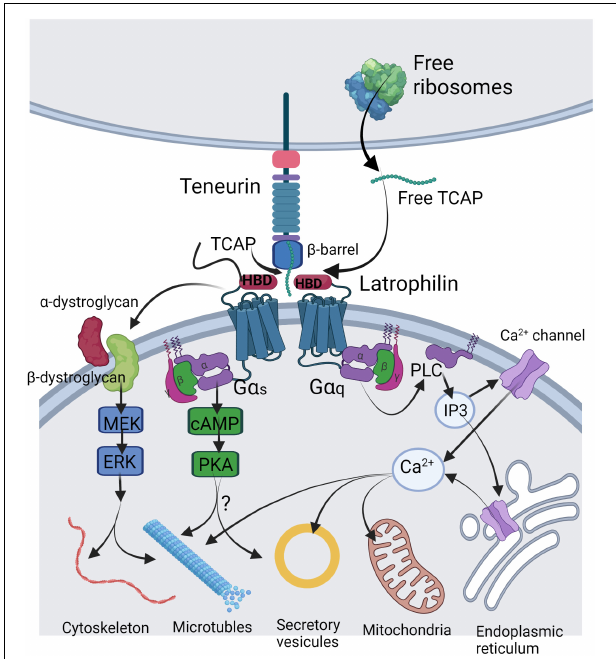
FIGURE 1 | Illustration of the mechanisms of TCAP release and its molecular targets in a generalized neuron. TCAP may be liberated by either autoproteolytic cleavage from the C-terminus of the teneurin or by translation of a short mRNA from the free ribosomes. Soluble TCAP binds to the hormone-binding domain (HBD) of latrophilin-1 or-3 leading to combination with the dystroglycan complex where it stimulates a MEK-ERK phosphorylation response to regulate cytoskeleton organization and microtubule assembly. Further, TCAP binding to latrophilin may lead to G α s activation to stimulate cAMP and PKA targeting vesicular release. A major action of TCAP appears to act via G α q to elicit activation of the PLC-IP3 signal cascade to induce changes in cytosolic Ca 2 + by acting on various Ca 2 + channels to target mitochondrial function. This image was created using